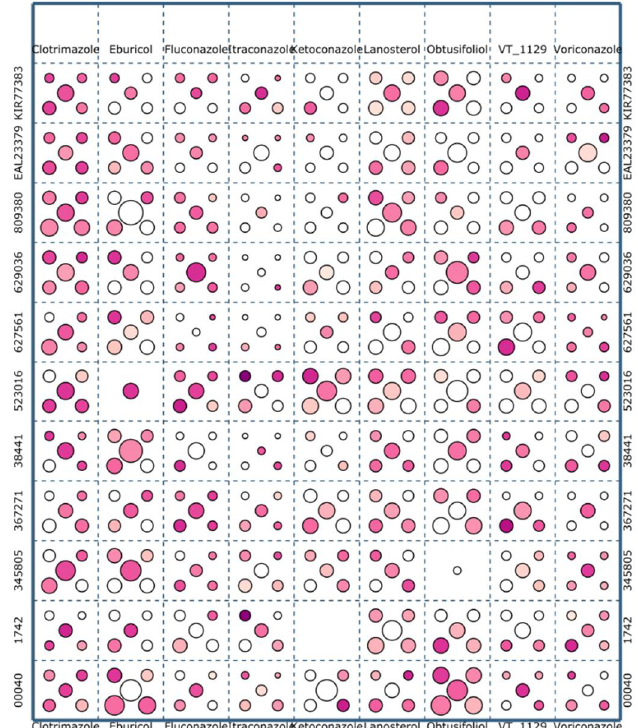
Figure 5. Graphical representation of results of hierarchical clustering. Each of the 99 squares dis- plays up to five clusters, represented by circles. The circular area is proportional to the size of the respective cluster, while the color scale denotes the d NFe distance, with darker colors representing shorter values. All clusters of at least 10 structures found by hierarchical clustering are marked on this figure.